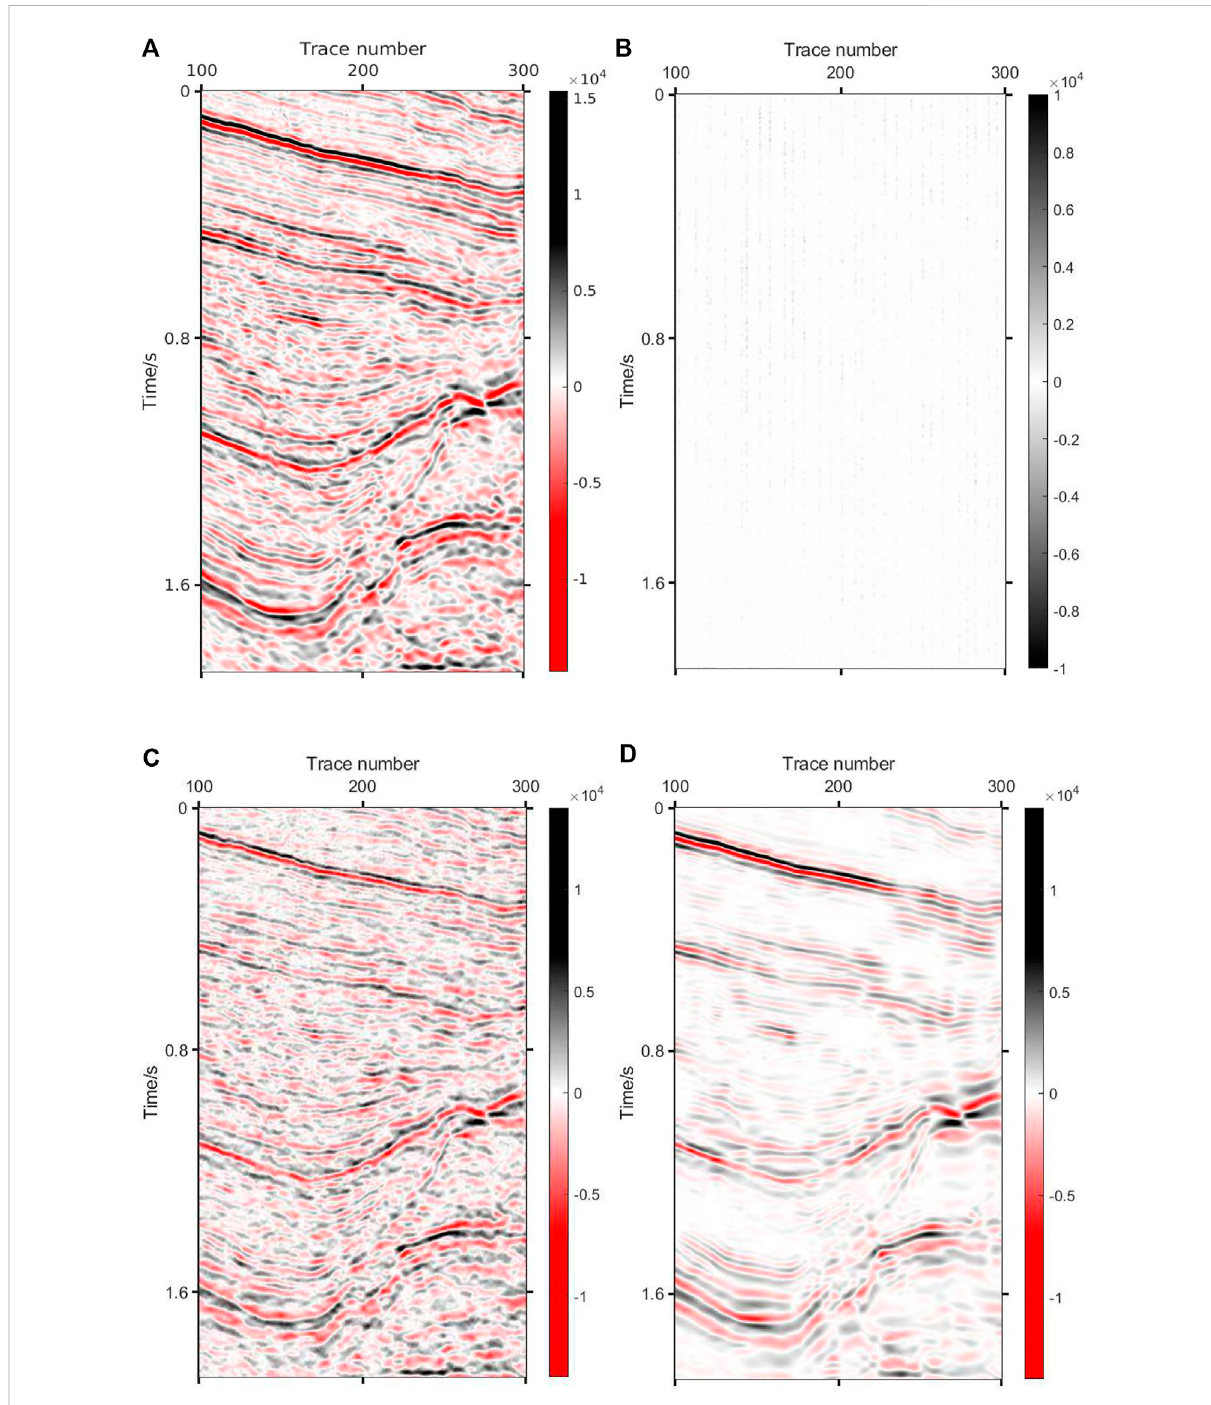
FIGURE 6 Result via DCT+K-SVD. (A) Result via DCT+K-SVD (SNR=12.1 dB PSNR=28.45 dB); (B) Absolute error via DCT+K-SVD; (C) Reconstruction component via K-SVD; (D) Reconstruction component via